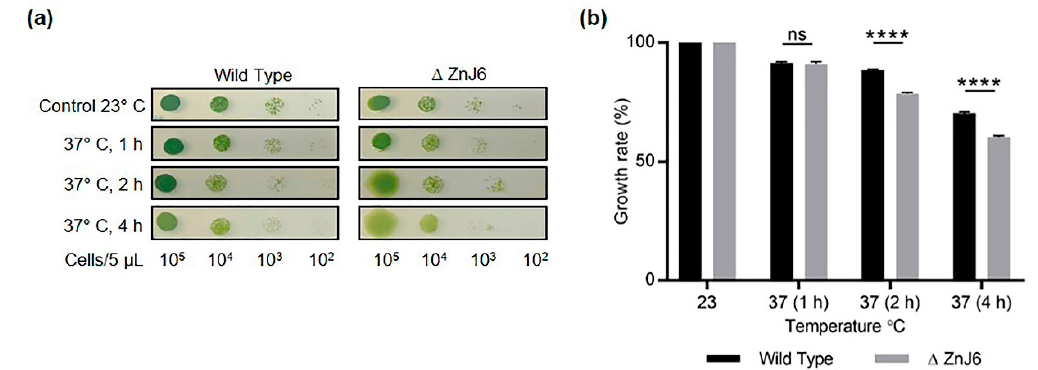
Figure 9. The ∆ ZnJ6 mutant is sensitive to heat stress. ( a ) Chlamydomonas cells (WT and ∆ ZnJ6) grown to mid-log phase in HS medium were serially diluted. Aliquots (5 µL) from each dilution were spotted on HS plates and incubated at 37 °C for 1, 2 and 4 h. Control plates were maintained at 23 °C . All the plates were then allowed to grow for 5 days under continuous illumination at 23 °C. Decreased growth and an increase in yellowing are observed in the ∆ ZnJ6 cells that were incubated at 37 °C for at least 2 h; ( b ) Densitometric analysis of the growth observed in panels a (taken from cells spotted at a dilution of 10 3 cells per 5 µL) using myImageAnalysis (Thermo Fisher Scientific) software. Growth at 23 °C was considered as 100%. The figure represents one of three repeats. The Student’s t- test was used to analyze the difference in growth between WT and ∆ ZnJ6; error bars show the standard deviation values (****: p value ≤ 0.0001, ns: not significant).